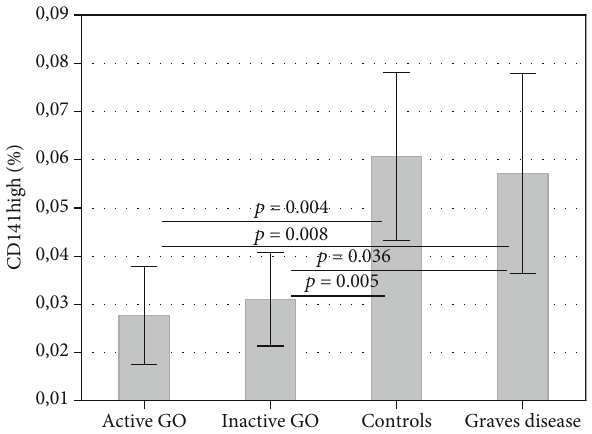
Figure 2: Percentage of mDCs (CD141+) in the peripheral blood of patients with active and inactive GO and controls and GD patients without GO. Data are presented as means ± standard deviation (SD) (ANOVA Kruskal-Wallis test).